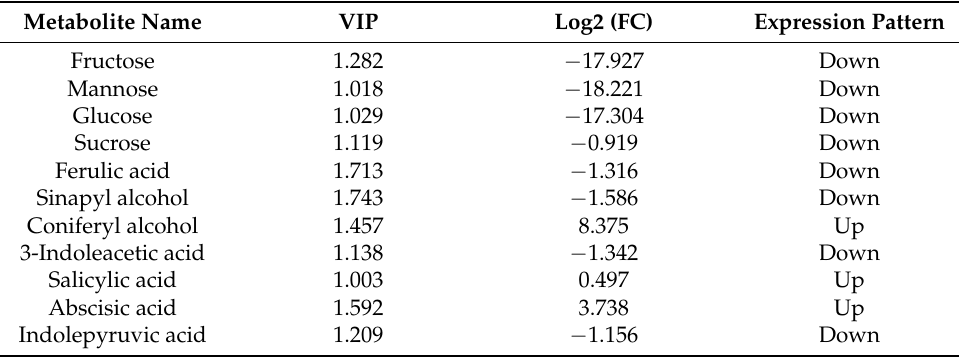
Table 3. Differential metabolites related to dwarf